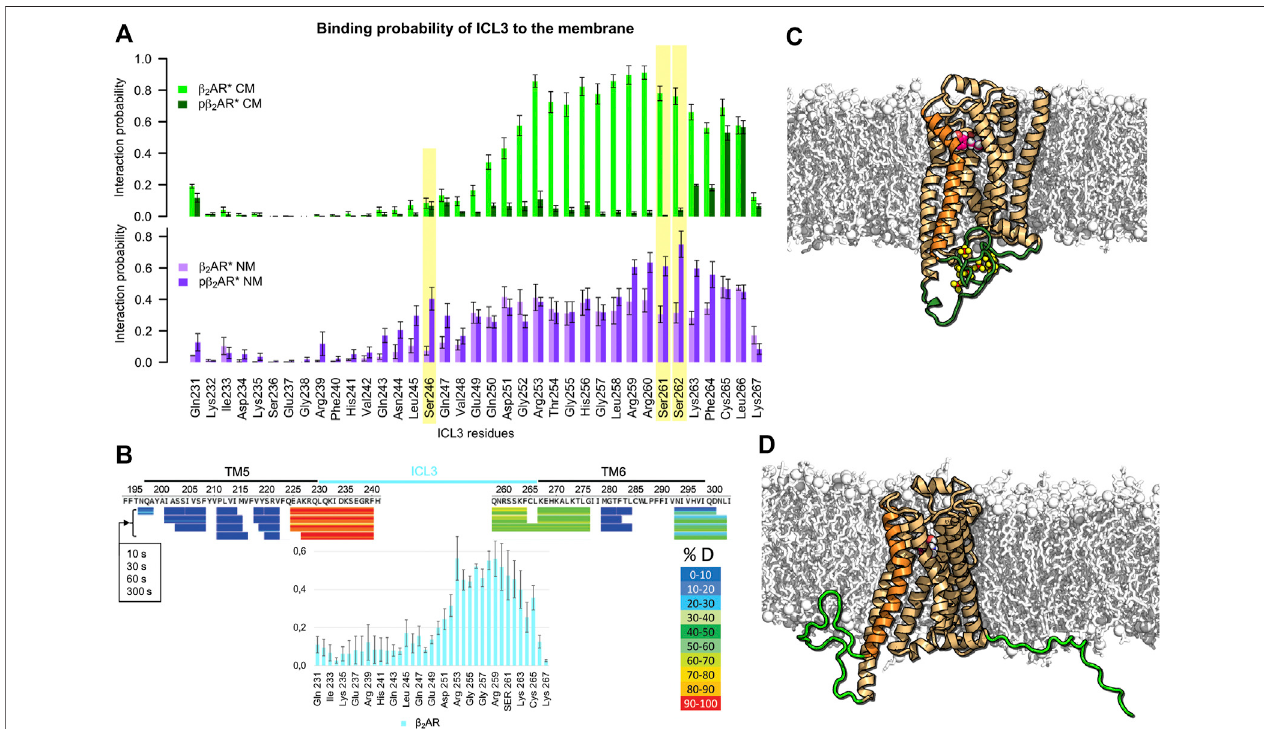
FIGURE 1 | Interactions of ICL3 with membrane depend on β 2 AR phosphorylation and lipid composition. (A) Probability of ICL3 interactions with charged (CM, greencolors)andneutral(NM,purplecolors)lipidmembranesforactive β 2 AR*indifferentphosphorylationstates(probabilitiesforthenonphosphorylatedreceptorinlight and phosphorylated in dark colors). Yellow background indicates residues that are phosphorylated in the respective data sets. Interaction probabilities were acquired from threeindependentREST MD simulations per lipidmembranecompositionand β 2 AR*phosphorylationstate. Errorbars givestandarderror ofthemeanover 6 analyzed time intervals (100 – 150 ns and 150 – 200 ns of each REST MD simulation at 310 K). (B) Comparison of the ICL3-membrane interaction probability in the inactive, nonphosphorylated state of β 2 AR (cyan bar plot at the bottom) embedded in the charged membrane to the hydrogen-deuterium exchange experiments on β 2 ARinactivatedbycarazolol(adaptedwithpermissionfrom(Zhangetal.,2010),copyright2010AmericanChemicalSociety).Thelowerhydrogen-deuteriumexchange (shown in green) at the cytoplasmic end of TM6 and the proximal ICL3 hint to reduced water accessibility as compared to the cytoplasmic end of TM5 and the adjacent part of ICL3 (shown in red/orange colors). Hydrogen-deuterium exchange times of 10, 30, 60 and 300 s are shown. (C) Phosphorylated active p β 2 AR* and (D) Nonphosphorylated active β 2 AR*. The receptor, displayed as orange cartoon with TM6 highlighted in brighter orange, is embedded in a negatively charged membrane (white sticks and spheres) consisting of DOPC, DOPG and cholesterol. ICL3 and C-terminus are highlighted in green, phosphorylated residues are shown asyellow/red spheres. Adrenaline is shown as magenta/white